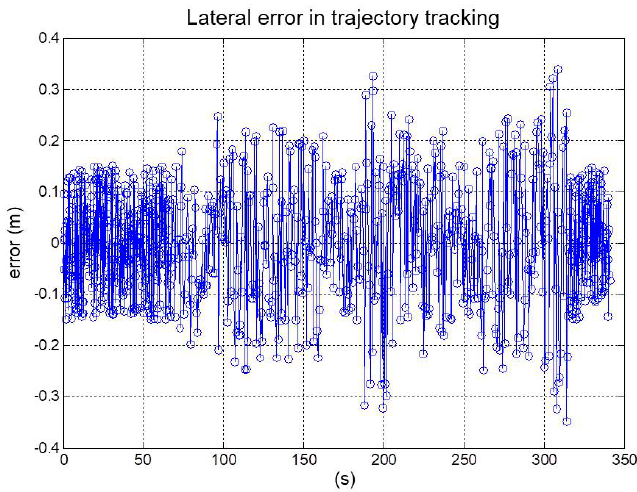
Figure 16. Lateral error during the tracking of the test lane.